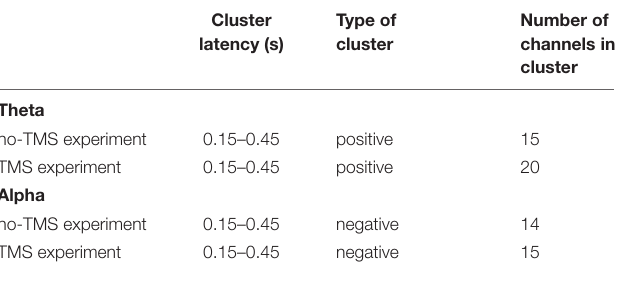
TABLE 1 | Significant clusters ( p < 0.05) between conditions (CS + and CS − ) that were compared regarding power in theta and alpha frequency bands using cluster-based